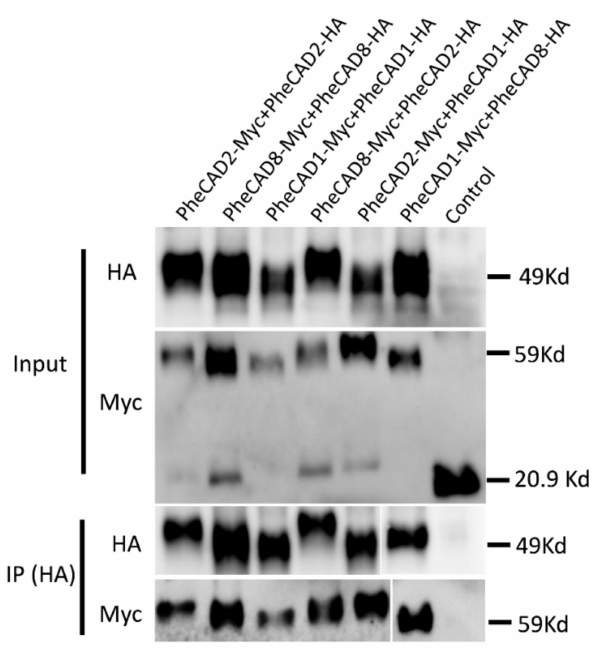
Figure 8. CO-IP assay of PheCAD1 , PheCAD2 and PheCAD8 enzymes using proteins expressed in N. benthamiana leaf epidermal cells BiFC assay. The proteins were immunoprecipitated with anti-HA antibodies and detected with both anti-HA and anti-Myc